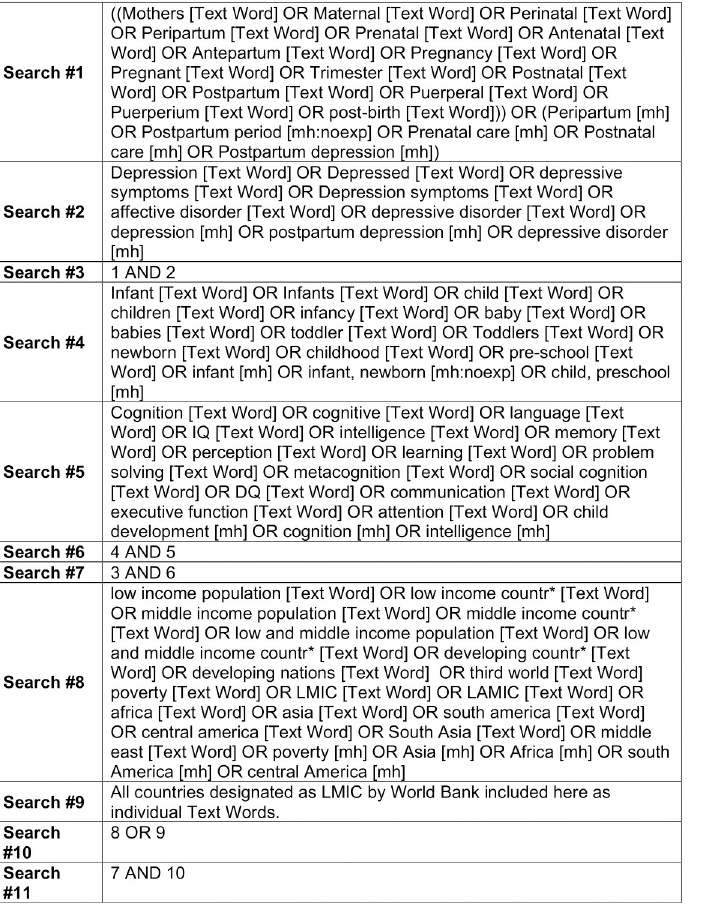
Fig 1. Example search strategy used with